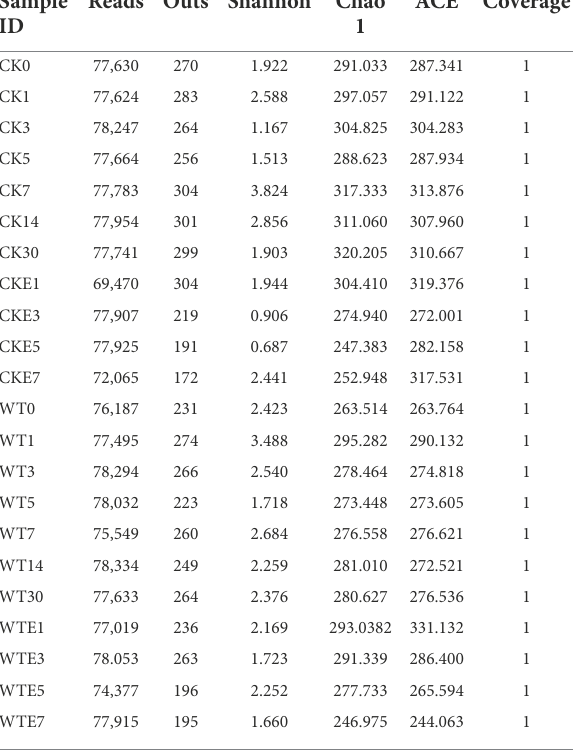
TABLE 3 Alpha diversity of bacteria in king grass ensiling process and after exposure to air. Sample